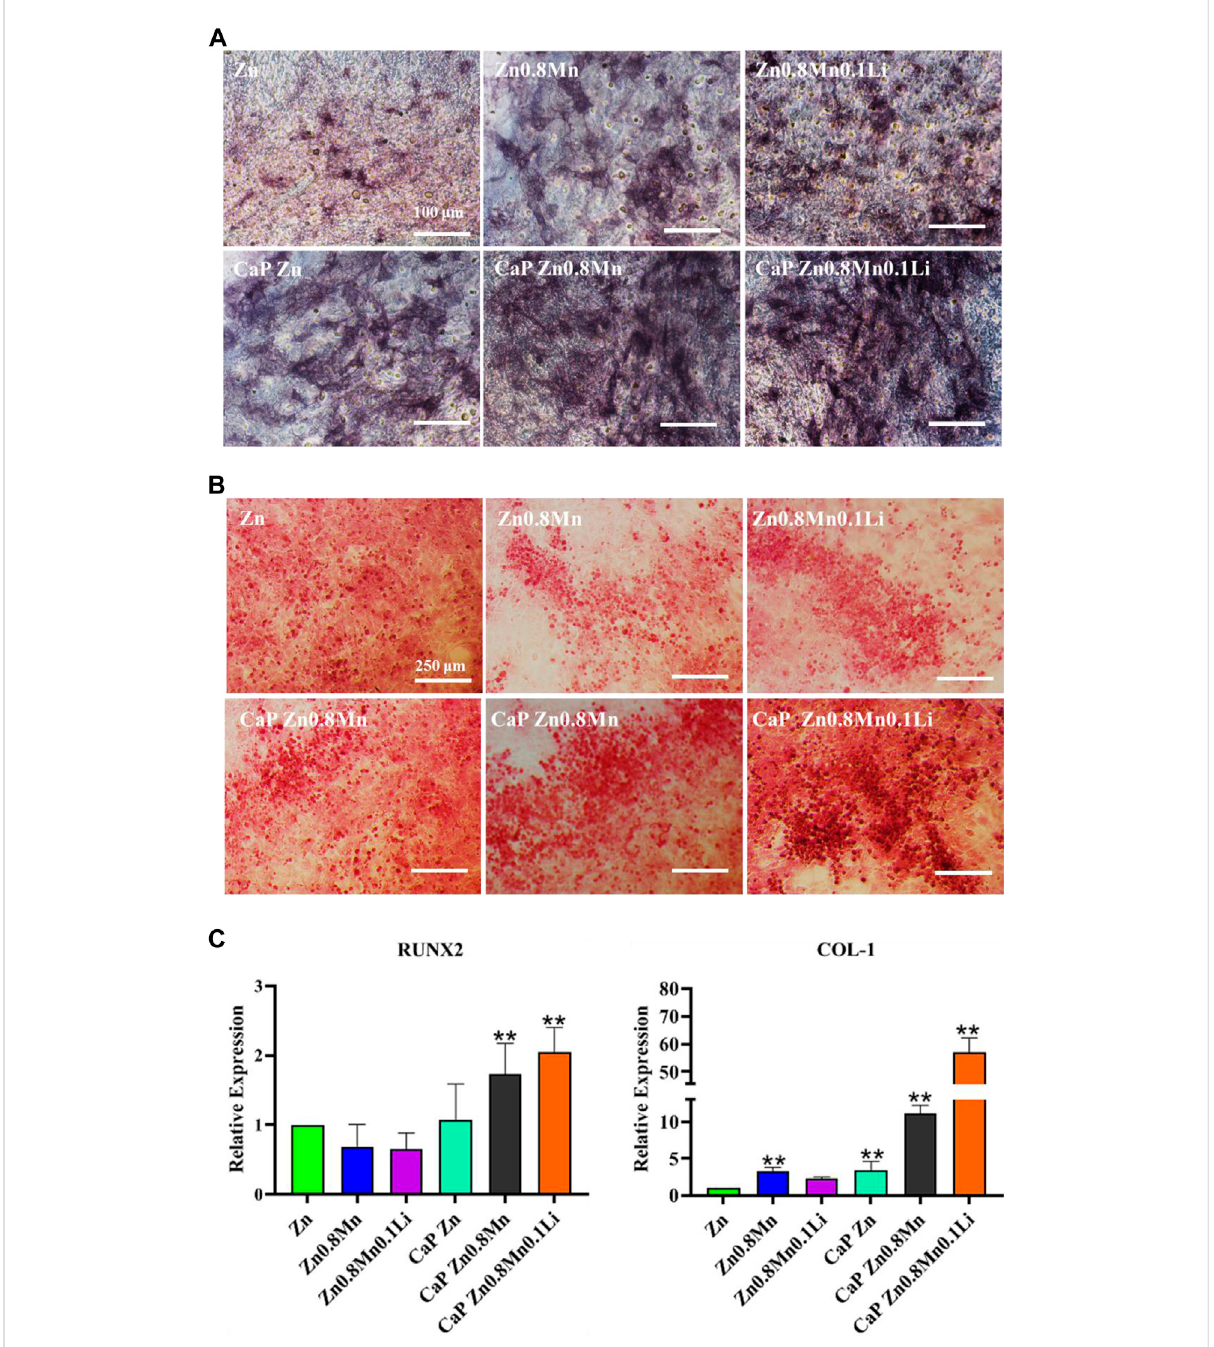
FIGURE 10 OsteogenicdifferentiationofMC3T3-E1cells. (A) ALPstainingandquanti fi cationinMC3T3-E1cells. (B) AlizarinredSstainingandquanti fi cation inMC3T3-E1 cells. (C) Theexpressionofosteogenic genewasdetected byqRT-PCR.* p < 0.05, ** p < 0.01 representsigni fi cantdifferencesbetween the indicated